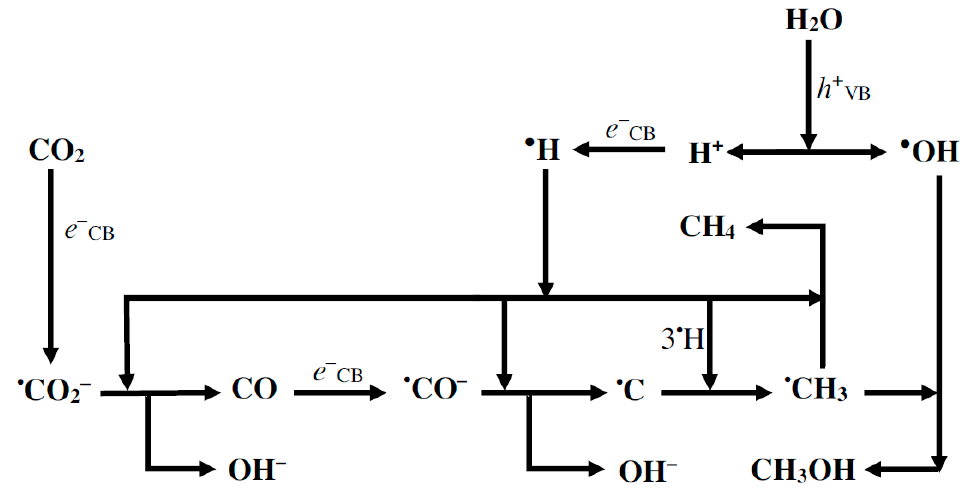
Figure 5. Gaseous phase photocatalysis of CO 2 and water: proposed reaction pathway. Reproduced from work in [39] . Copyright 2016 Elsevier Ltd.